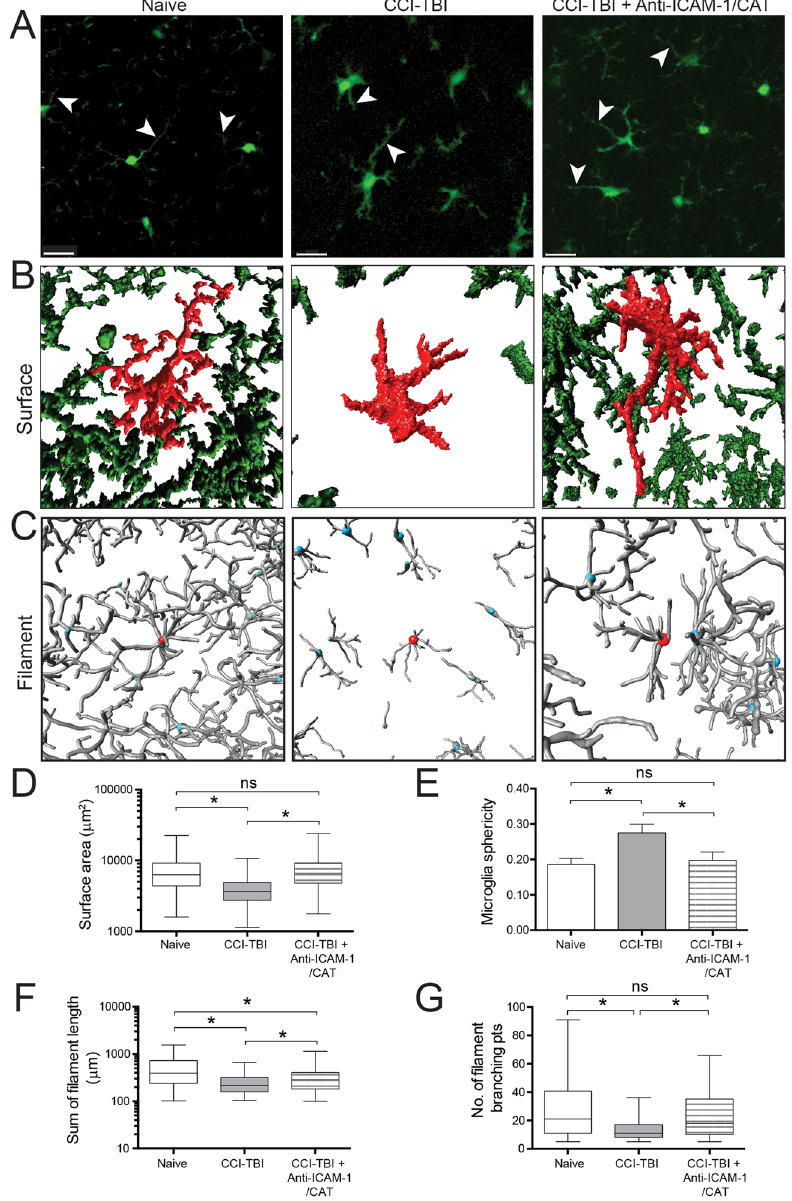
Figure 7. Two-photon imaging detection of microglia in CX3CR1-GFP mice and morphometric analysis of cellular morphology in CCI-TBI and anti-ICAM-1/catalase administration. CX3CR1-GFP mice (B6.129P- Cx3cr1 tm1Litt /J, The Jackson Laboratory) were subjected to moderate CCI-TBI with and without anti-ICAM-1/ catalase conjugate administration 30 min after impact. No craniectomy (naive) CX3CR1-GFP mice served as control. At 48 hrs following CCI-TBI, subjects were perfusion fixed, brain tissue was collected and subsequently sectioned into 1 mm segments for two-photon imaging. ( A ) Representative single slice images depict microglial ramification in the area of impact for naive, CCI-TBI, and CCI-TBI + anti-ICAM-1/catalase mice. Arrowheads point to microglial processes, which are finely ramified in the naive condition and thicken and retract following CCI-TBI. Anti-ICAM-1/catalase attenuates changes in microglia cell body enlargement and process retraction. Scale bar 20 μ m. Imaris (Bitplane) software was utilized for 3D reconstruction of GFP-expressing microglia from z-stack images obtained by two-photon microscopy. ( B ) Surface rendering was performed for microglia based on GFP signal threshold to measure cellular surface area ( D ) (only objects with surface area > 1000 μ m 2 were analyzed) and sphericity ( E ). ( C ) Imaris FilamentTracer was employed to map microglial processes to quantify changes in cell ramification in CCI-TBI. Microglial total filament length ( F ) and number of filament branching points (complexity, ( G ) and were assessed for naive, CCI-TBI, and CCI-TBI + anti-ICAM-1/catalase groups. Data presented at mean ± SD. (Ordinary one-way ANOVA. Surface area: F = 73.12, P < 0.0001. Sphericity: F = 17.20, P = 0.0013. Sum of filament length: F = 74.57, P < 0.0001. Number of filament branching points: F = 38.50, P <